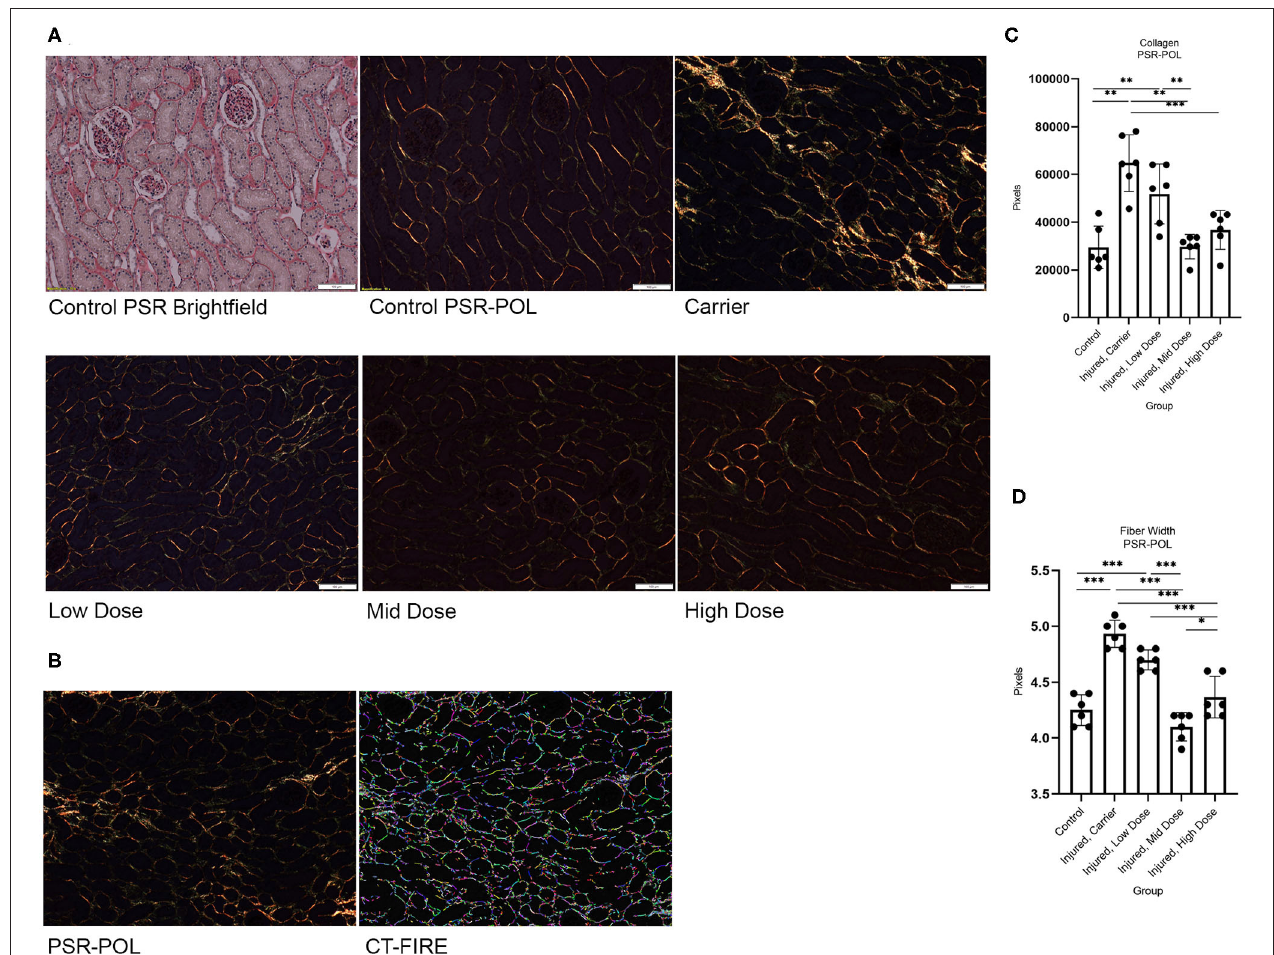
FIGURE 4 | (A) Histology of left kidney CMJ stained with PSR and PSR-POL under 100 × magnification for each study group. I/R (Carrier) increased birefringent collagen fiber signal. CXCL12 Treatment restored I/R-induced changes in birefringent collagen fiber signal in a dose-dependent manner. (B) PSR-POL image used to calculate total collagen in pixels and segmentation software CT-FIRE-generated image used to quantify collagen fiber length and width. (C) One-way ANOVA for collagen fiber width for each group on PSR-POL showed a significant group effect, F (4,25) = 36.634, p < 0.001; and (D) One-way ANOVA for total